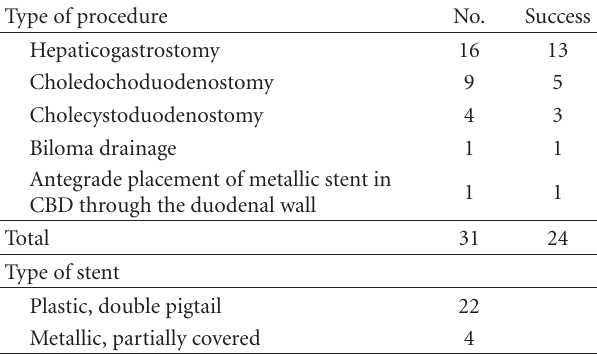
Table 2: Type of drainage, success rate, and type of stent